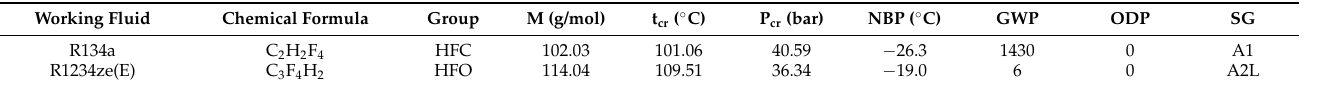
Table 2. Parameters of refrigerants in the